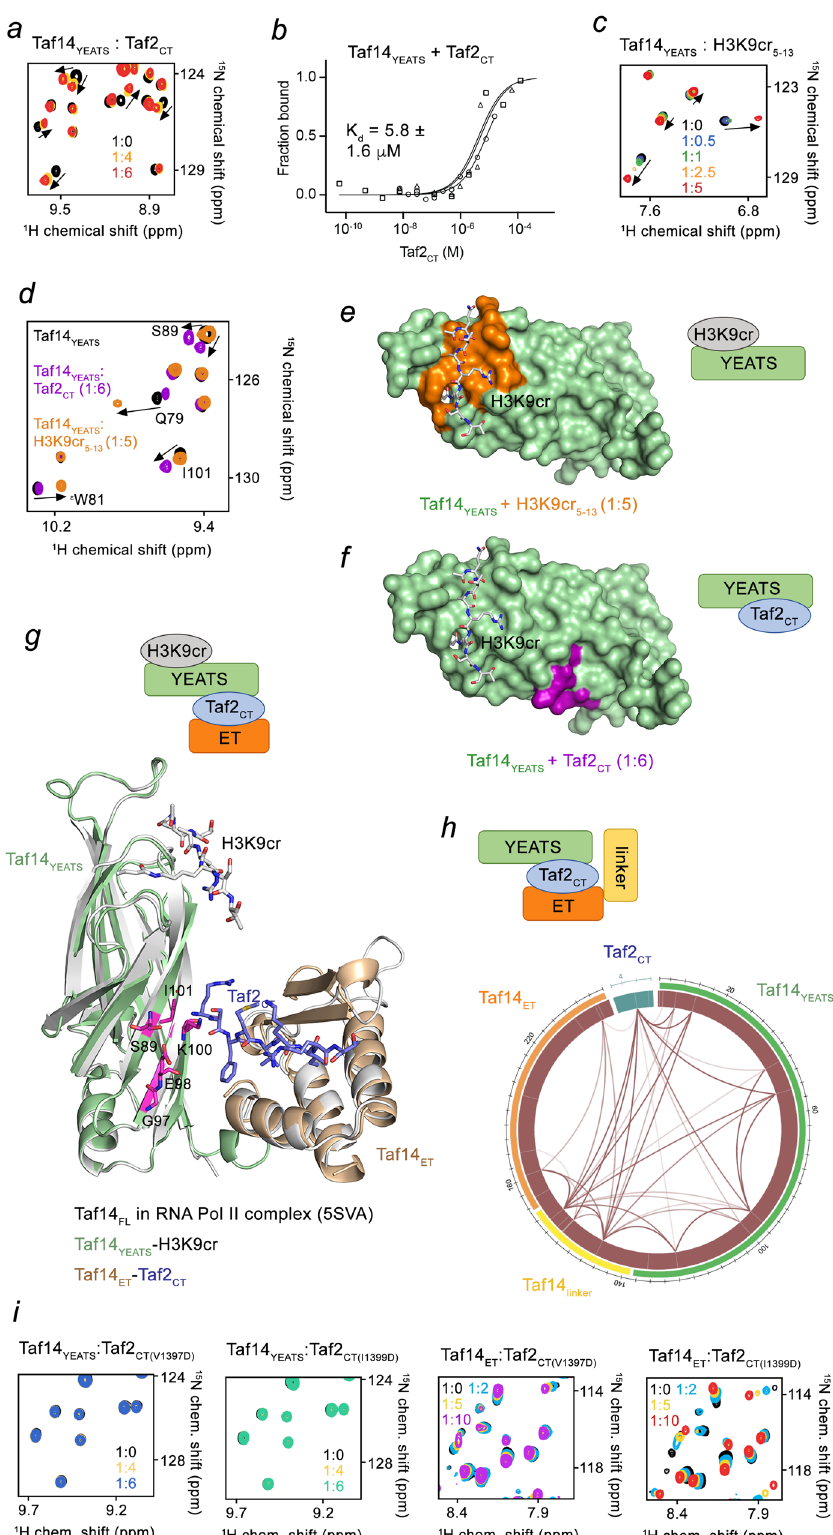
that the domains are not fully independent and interactions or conformational changes occur within Taf14 FL (Supplementary Fig. 9). We note that the conformational rearrangement and the ternary structure of Taf14 FL did not reduce binding to H3K9cr, indicating that the H3K9cr binding site in Taf14 remains acces- sible (Fig.